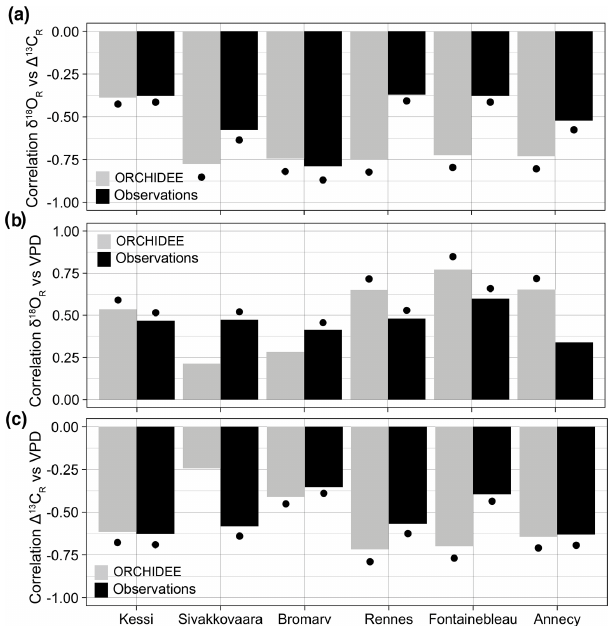
Figure 4. Observed and simulated isotopic coupling and response to VPD across the climate gradient during 1960–2000. (a) Correlation between δ 18 O R and (cid:49) 13 C R in simulations (gray) and observations (black). (b–c) Correlations between growing season VPD and sim- ulated (gray) and observed (black) δ 18 O R and (cid:49) 13 C R variability, respectively. For Annecy the period of analysis is 1971–2000. Sig- nificance at the 95% confidence level is indicated by the black dots.